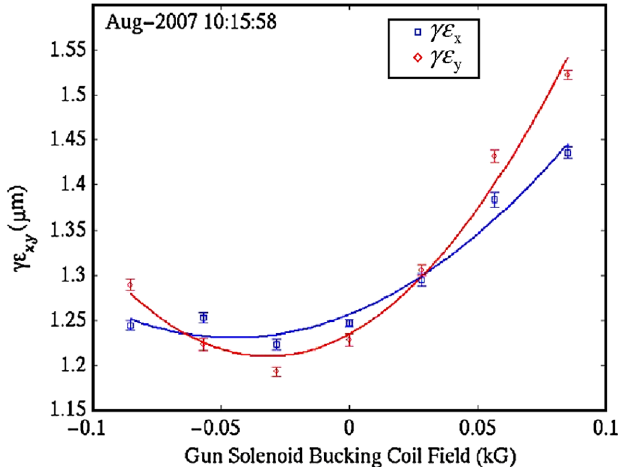
FIG. 11. (Color) Horizontal (blue) and vertical (red) emittance at 135 MeV optimized (parabolic fits) by varying the gun- solenoid’s bucking coil field. The minimum emittance occurs close to the expected value of (cid:1) 0 : 027 kG